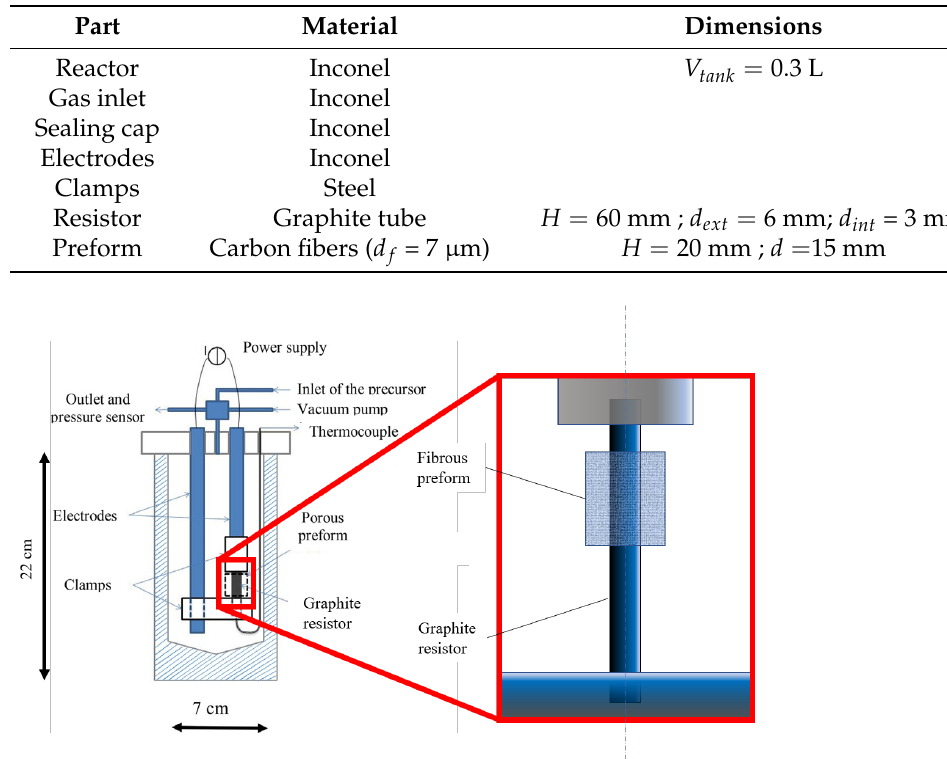
Figure 1. Scheme of the setup, with the porous preform settled around the graphite